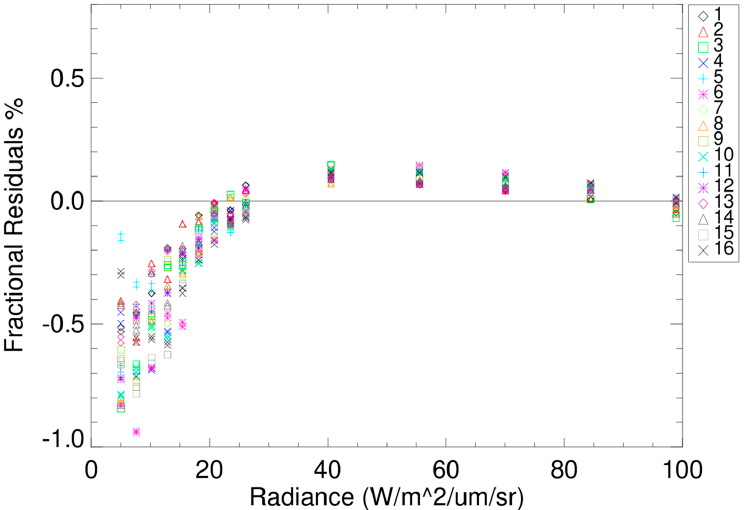
Figure 17. Band M8 fit residuals as a function of SIS100 radiance within the Lmin and Lmax regions for all detectors (colors and symbols) using a second-order polynomial fit. Equation (10) was then used to perform the regression in a similar fashion as the VNIR bands. Figure 18 shows the band M8 fit residuals, like Figure 17, using the third- order polynomial regression fit. The residuals at the lower radiance region and above a radiance of 50 show improvement over the second-order model. A fourth-order polyno- mial fit (not shown here) improved the performance even more than the third order, but the on-orbit SDR algorithm does not support it. Therefore, a third-order regression model was used to compute the SWIR band calibration coefficients for the on-orbit SDR LUTs. Figure 19 shows an example of band M8, HAM A fit coefficients in a similar style to the band M1 values in Figure 15. The first row is the coefficients with no fixed parameters, the second row 𝑐 0 𝑐 1 is set to zero, the third row has the tau fixed to the detector, and 𝑐 0 𝑐 1 fixed